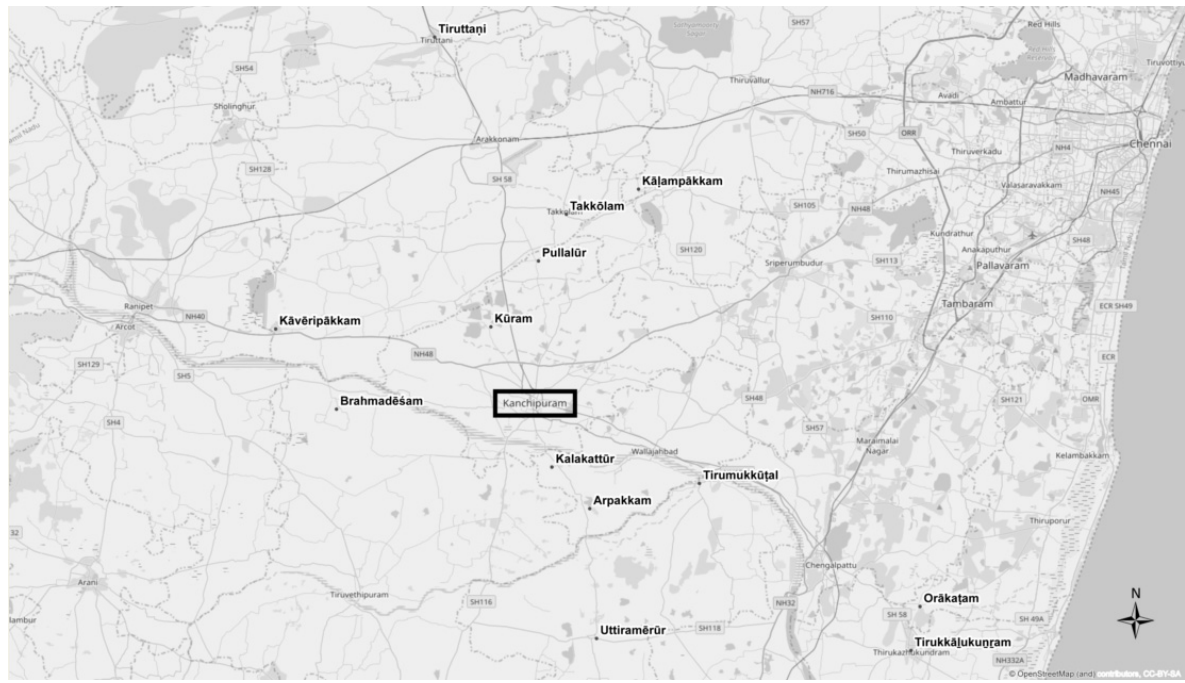
Figure 11. Map of temple sites around Kanchi, 9th century. Emma Natalya Stein and Daniel Cole, Smithsonian Institution.